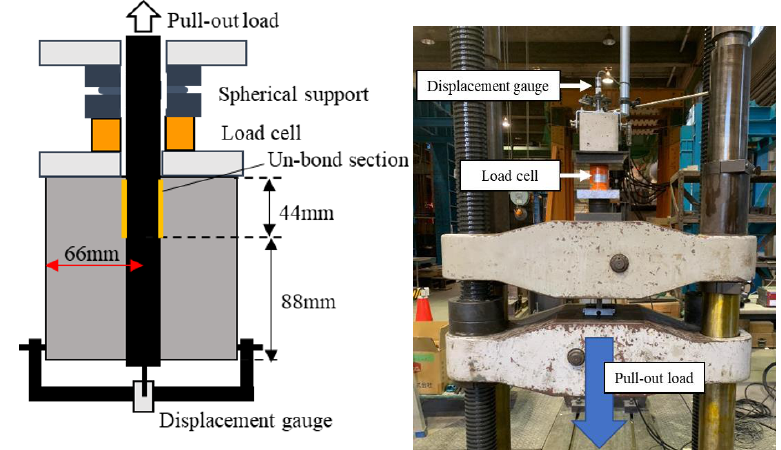
Figure 9. Outline of pull-out test.